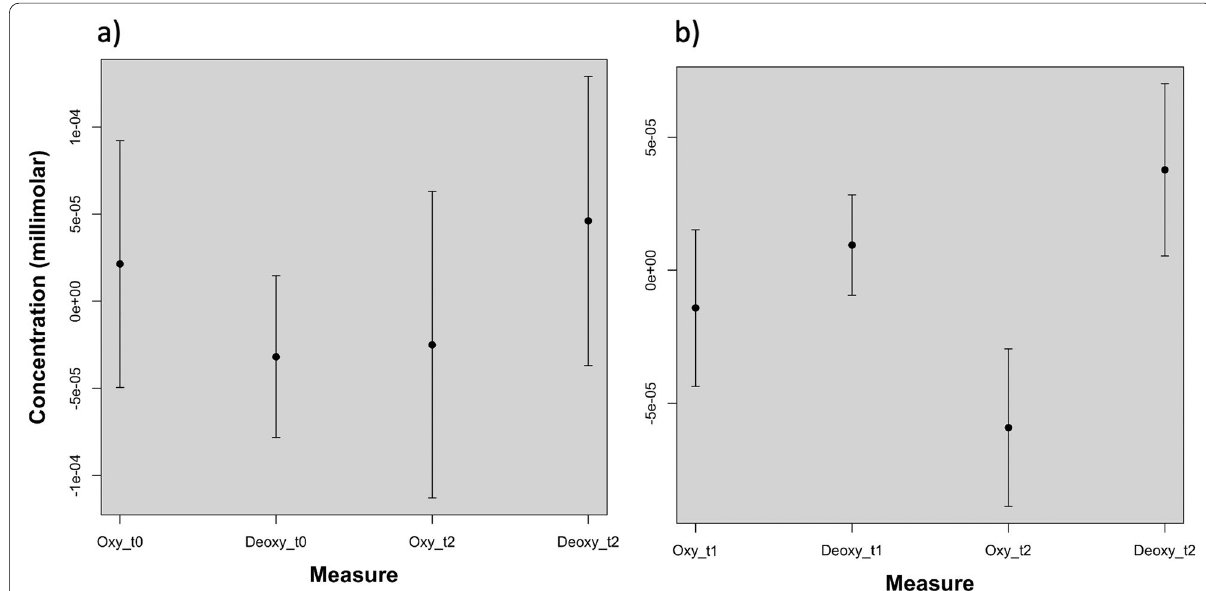
Fig. 9 Plots reporting the values of oxyhemoglobin and deoxyhemoglobin levels averaged over the channels proved to be significant with the Student’s t test. In a) the comparison between T0 and T2 in b) the comparison between T1 and T2 ( p < 0.01 for oxy and